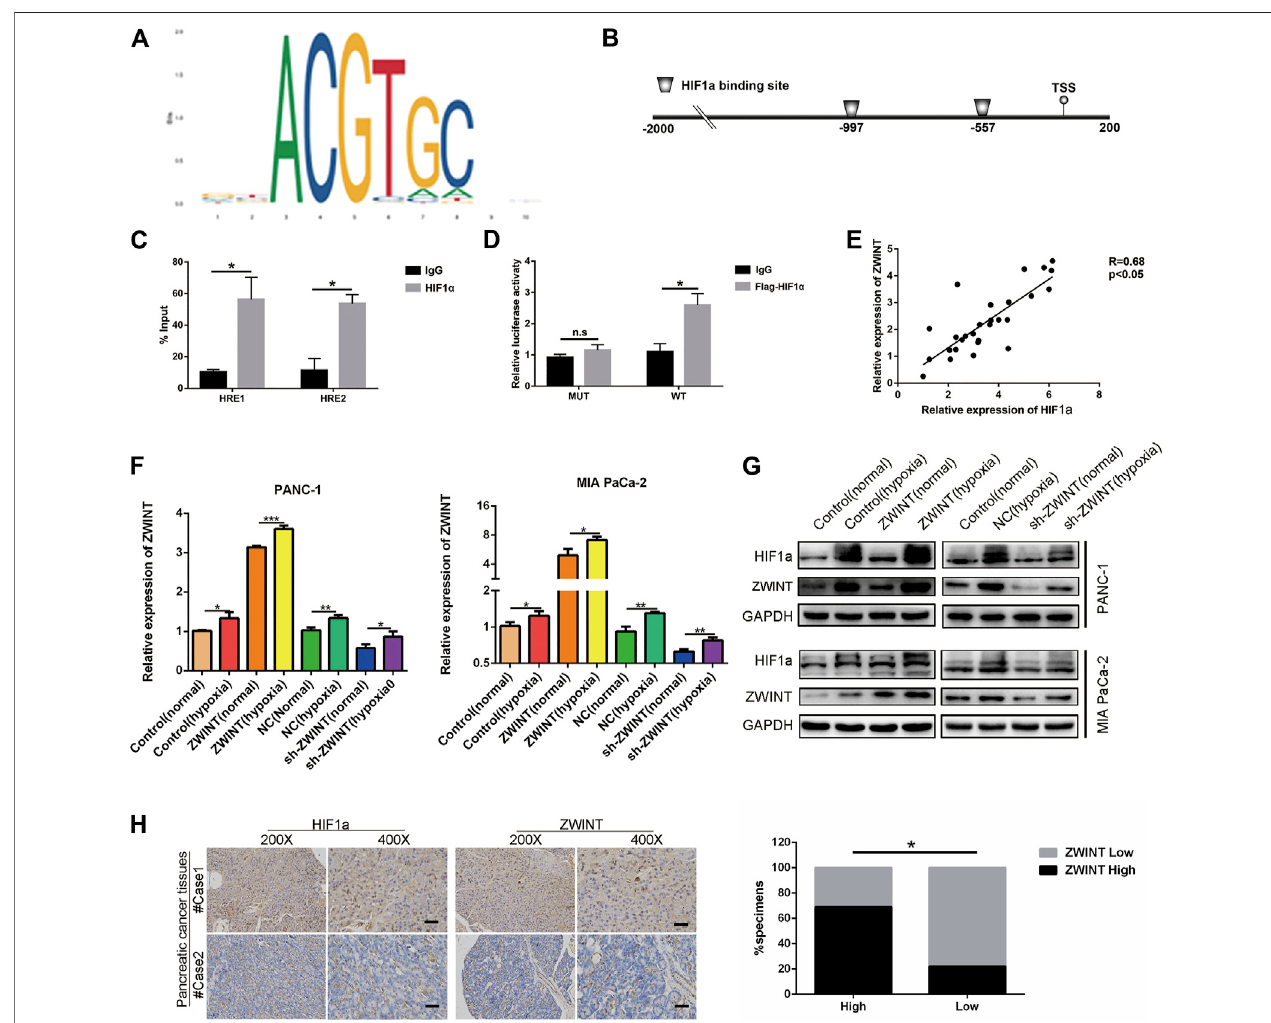
FIGURE 3 | ZWINT was a direct transcriptional target of HIF-1 α . (A) Bioinformation analysis the promoter sequence region. (B) Schematic diagram indicated the potential promoter binding region. (C) HEK293 cells were transfected with pGL3 reporter vector containing ZWINT wide-type promoter (HRE-WT), or mutant-type promoter (HRE-MUT), respectively. Those transfected cells were further treated under normoxia or hypoxia. After 48 h, fi re fl y luciferase activity was detected and normalized by renilla activity. (D) ChIP assay with anti-HIF-1 α antibody was performed to verify the binding between HIF-1 α and two HREs in ZWINT promoter in PANC-1 cells. (E) Pearson correlation analysis was performed to test the correlation between ZWINT and HIF1 α . (F, G) The mRNA and protein expression levels of ZWINT and HIF-1 α in PC cells were measured after culturing under normoxia, hypoxia(CoCl 2 , 100 μ M)) for 24 h by qRT-PCR and Western blot. (H) q-RT-PCR and IHC analysis the correlation of HIF-1 α and ZWINT in the pancreatic cancer tissues. Data shown are mean ± SD ( n (cid:2) 3). (* p < 0.05, ** p < 0.01, *** p < 0.001).